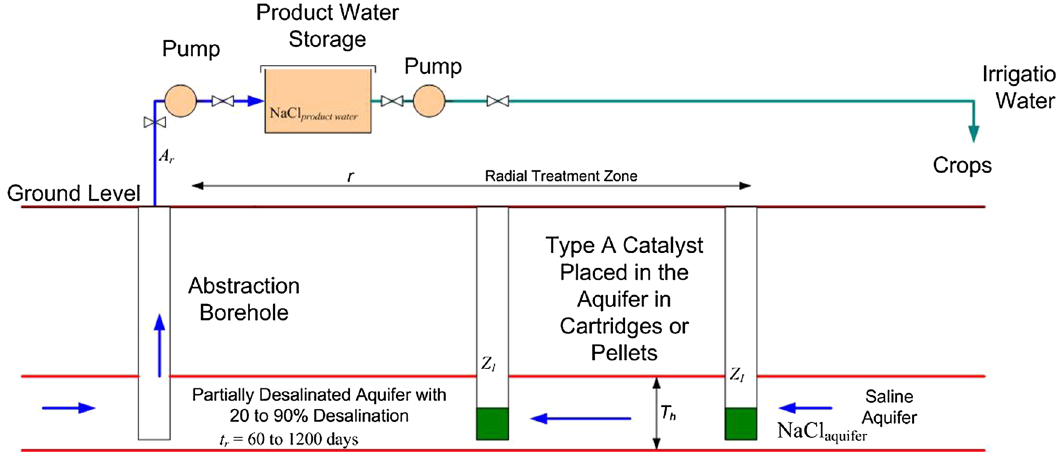
Fig. 12 Process flow diagram for the partial desalination of an aquifer using a Type A